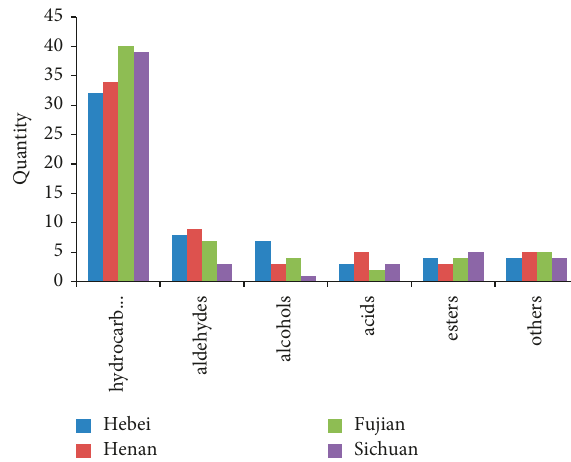
Figure 3: Volatile components types of T . fuciformis from different producing areas.